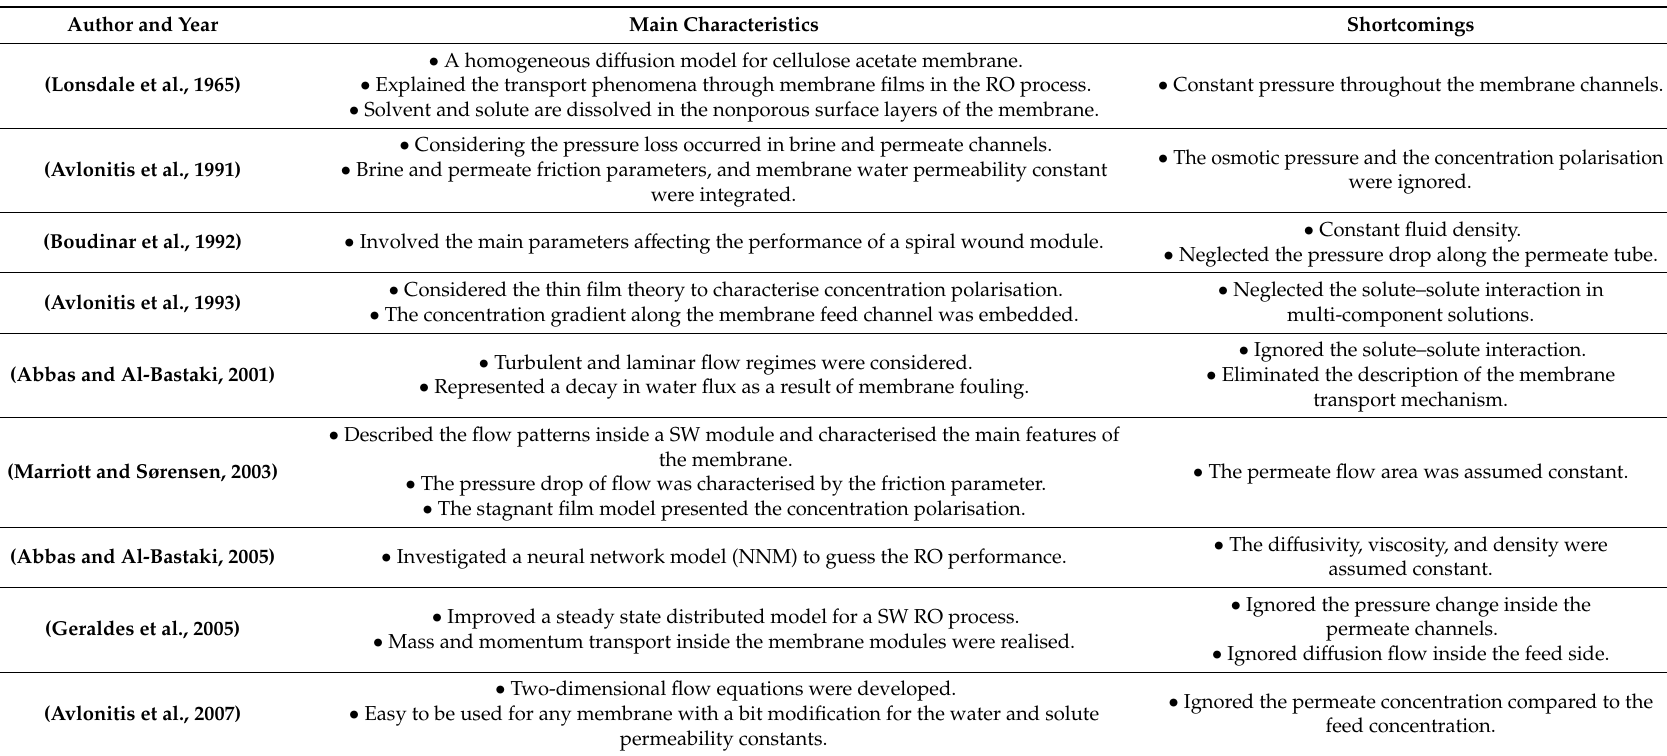
Table 1. Summary of the models developed for spiral wound reverse osmosis (RO)